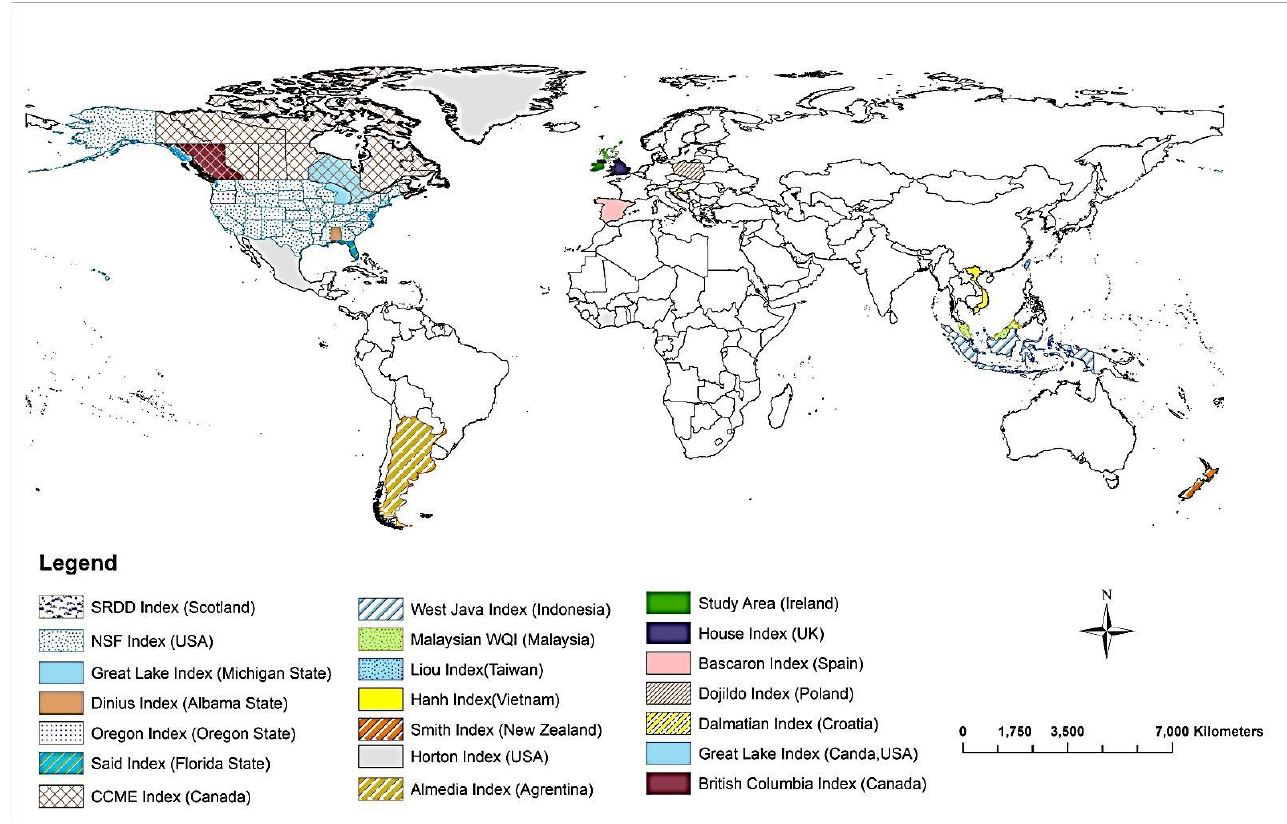
Figure 1. Commonly used WQI models worldwide [15].